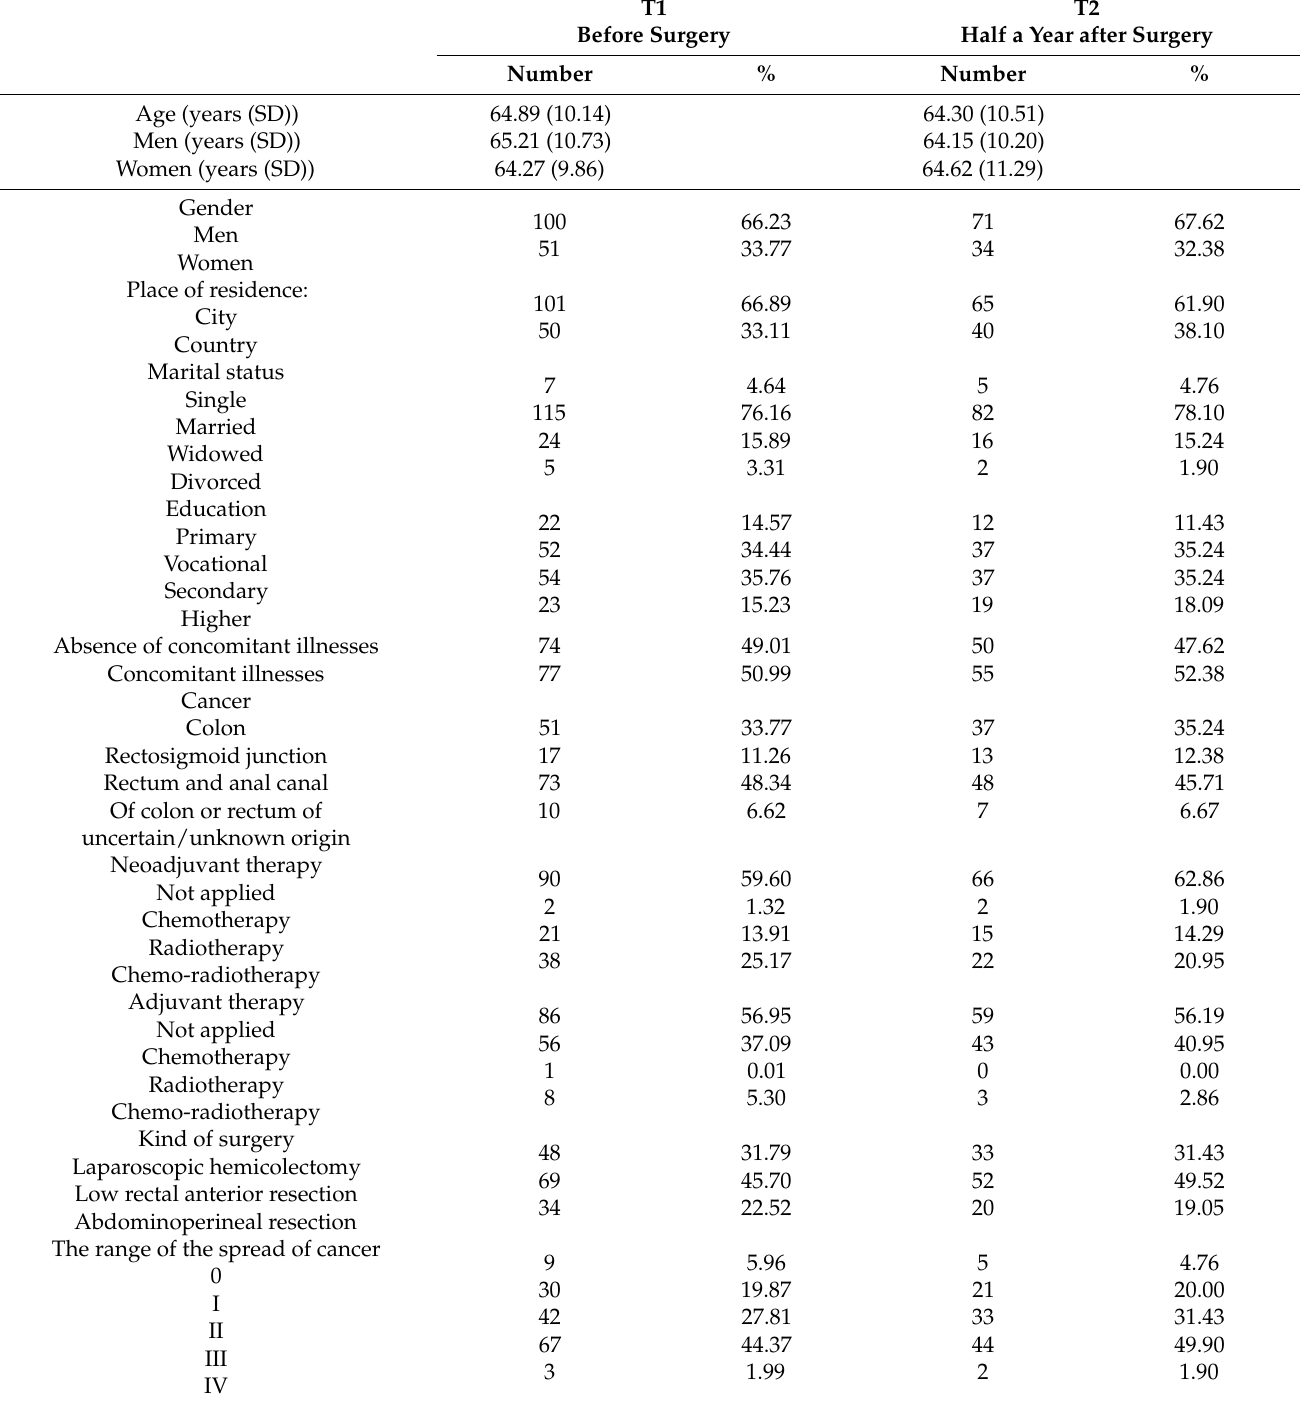
Table 1. Participants’ characteristics in each sample group before surgery ( n = 151) and half a year after the surgery ( n = 105). T1 Before Surgery